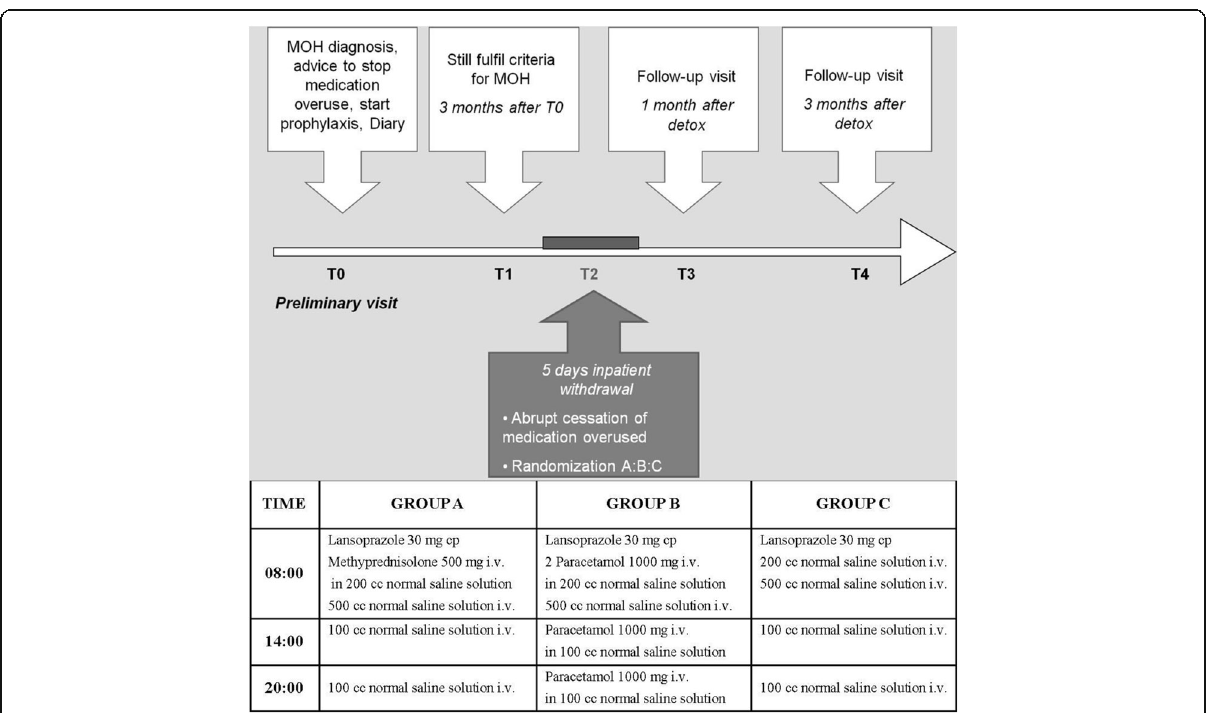
Fig. 1 Study design and treatment groups. A: Methyprednisolone group; B: Paracetamol group; C: Placebo group; MOH Medication Overuse